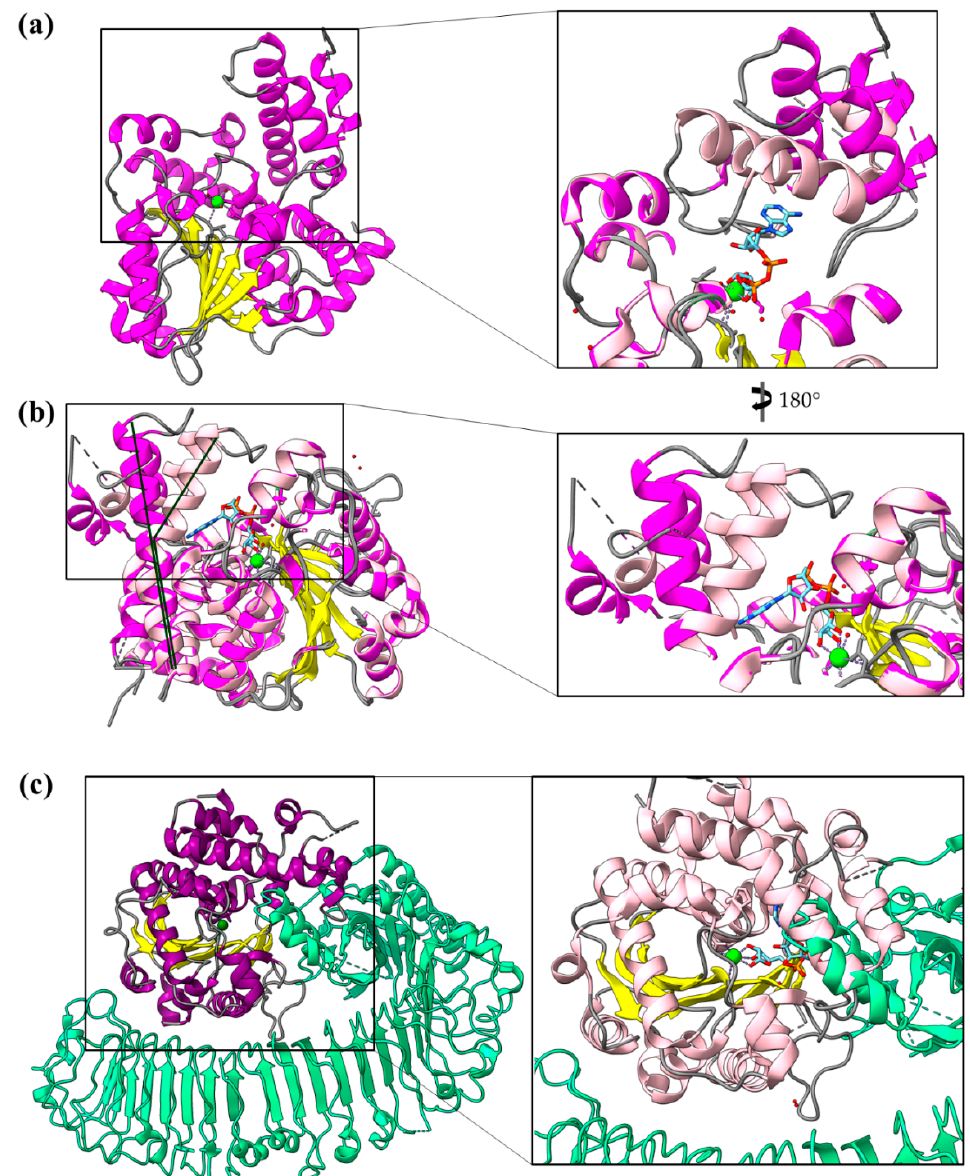
Figure 12. XopQ structure and conformational changes. ( a ) The structure of Xanthomonas XopQ is a Rossmann fold imple- mented with a mobile helical segment able to function as a lid of the active site upon substrate binding (PDB id 4KL0). ( b ) Closure of the active site is achieved via a bend which occurs in the middle of a long helix (PDB id 4P5F). The dark and light tones of magenta indicate the open and closed conformations of XopQ protein, respectively. ( c ) Left panel: The struc- ture of XopQ (magenta/yellow) in complex with the Roq1 (green) indicates that the latter inserts a helical segment into the active site cleft of XopQ (PDB id 7JLU). Right panel: Close-up of the complex. In the structure, the XopQ has been substi- tuted by a superimposed closed conformation. It is evident that the Roq1 helix insertion overlaps with the XopQ helical- lid in the closed